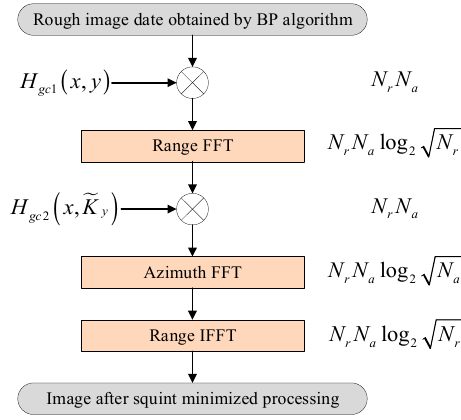
Figure 9. Diagram of the computational load of the squint minimization process.